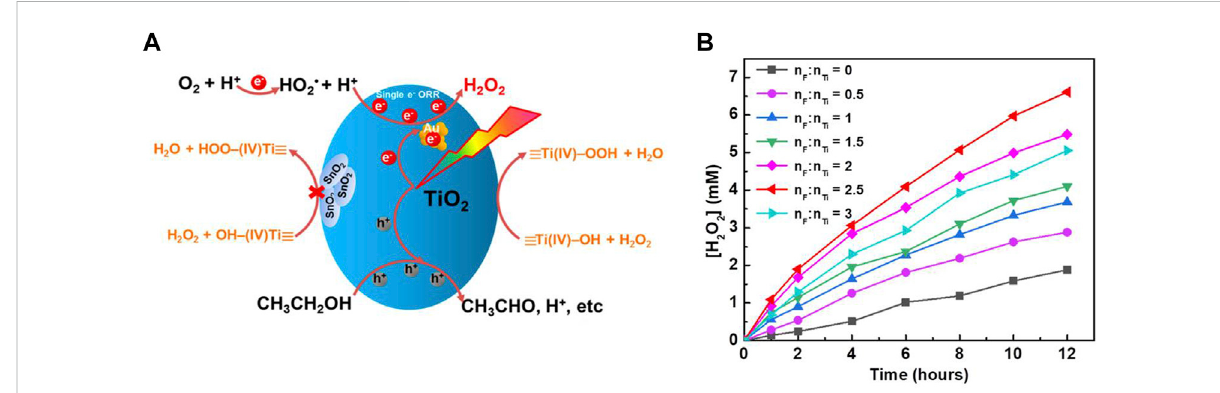
FIGURE 3 (A) SchematicillustrationofH 2 O 2 synthesisanddecompositionoverAu/SnO 2 -TiO 2 (Zuoetal.,2019b). (B) PhotocatalyticH 2 O 2 productionover 0.1%